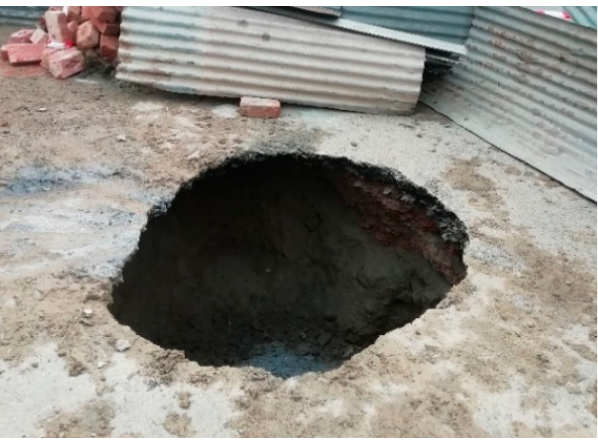
Figure 1. Road collapse due to an underlying pipe failure.